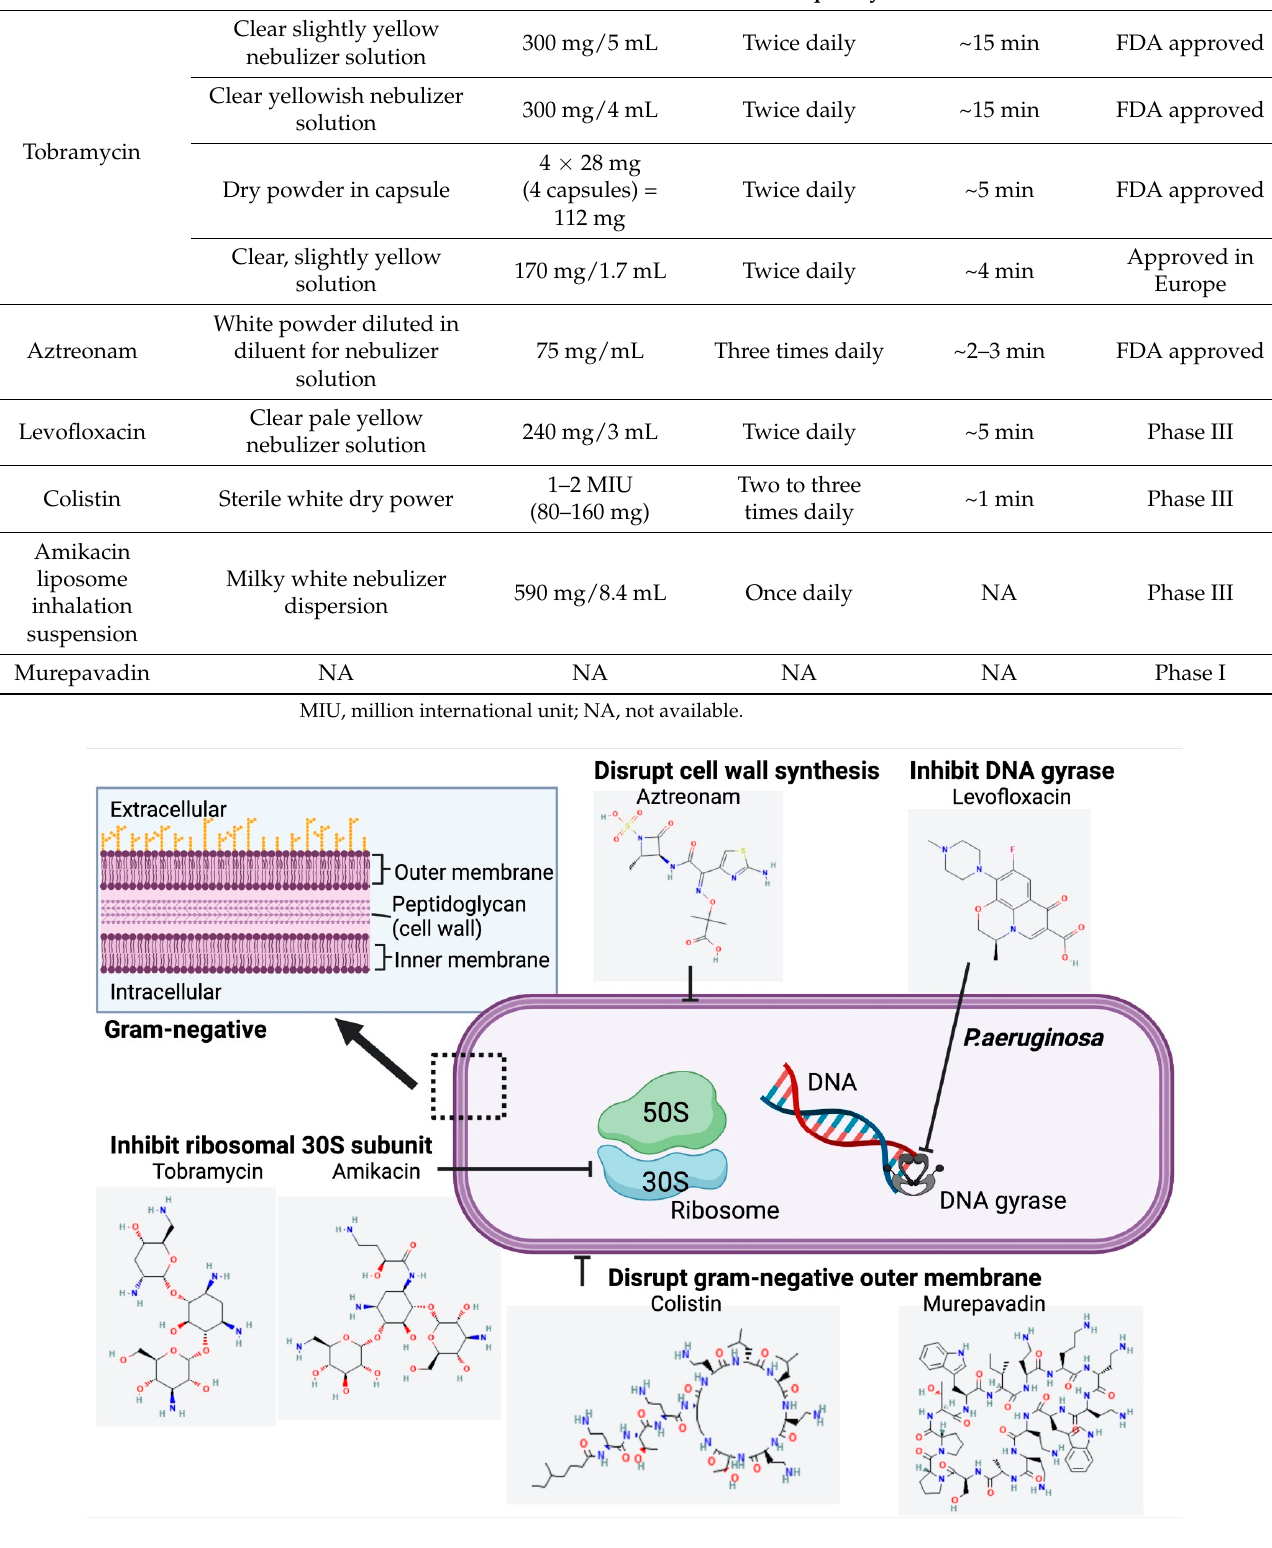
Figure 4. Structure and Mechanism of Action of Inhaled Antibiotics Targeting Chronic P. aeruginosa Infection in CF. Chemical structures accessed from PubChem [31–36]. Table 1. Summary of Inhaled Antibiotics to Treat Chronic P. aeruginosa Pulmonary Infections in CF Patients.